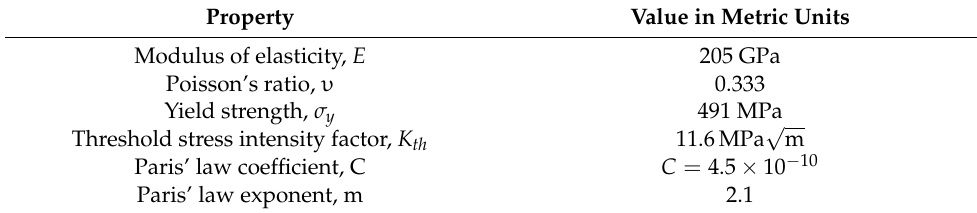
Figure 2. Initial mesh of the four-point bending beam. Table 1. Materials properties for cold-rolled SAE 1020